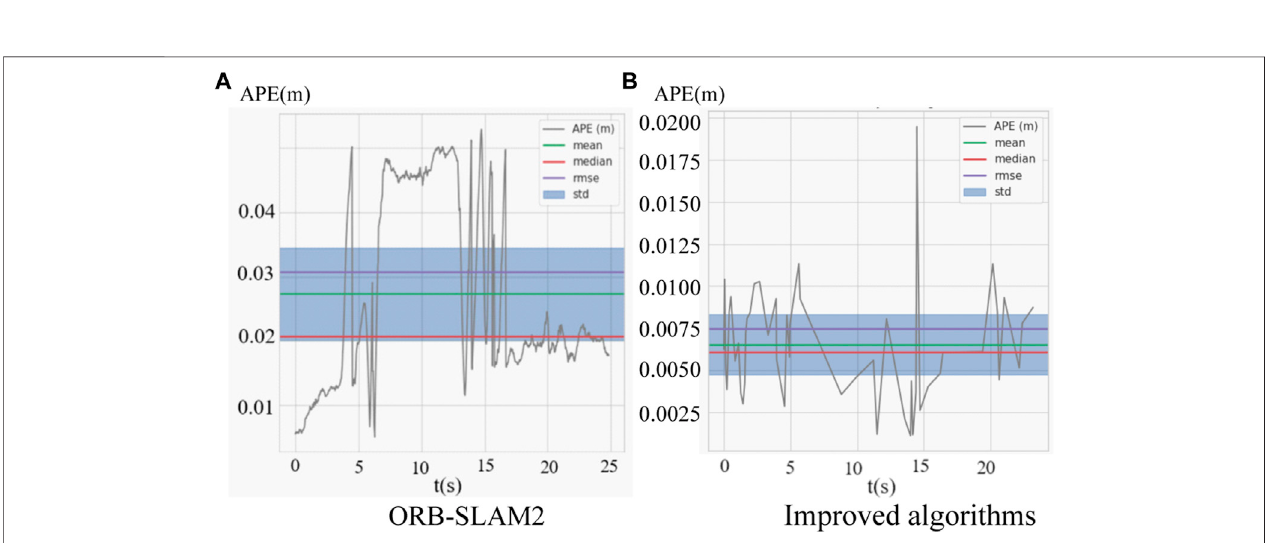
FIGURE10 | (A) isthe absolute trajectory error distribution ofthe combined improved algorithm, (B) isthe absolute trajectory error distribution of theORBSLAM2.